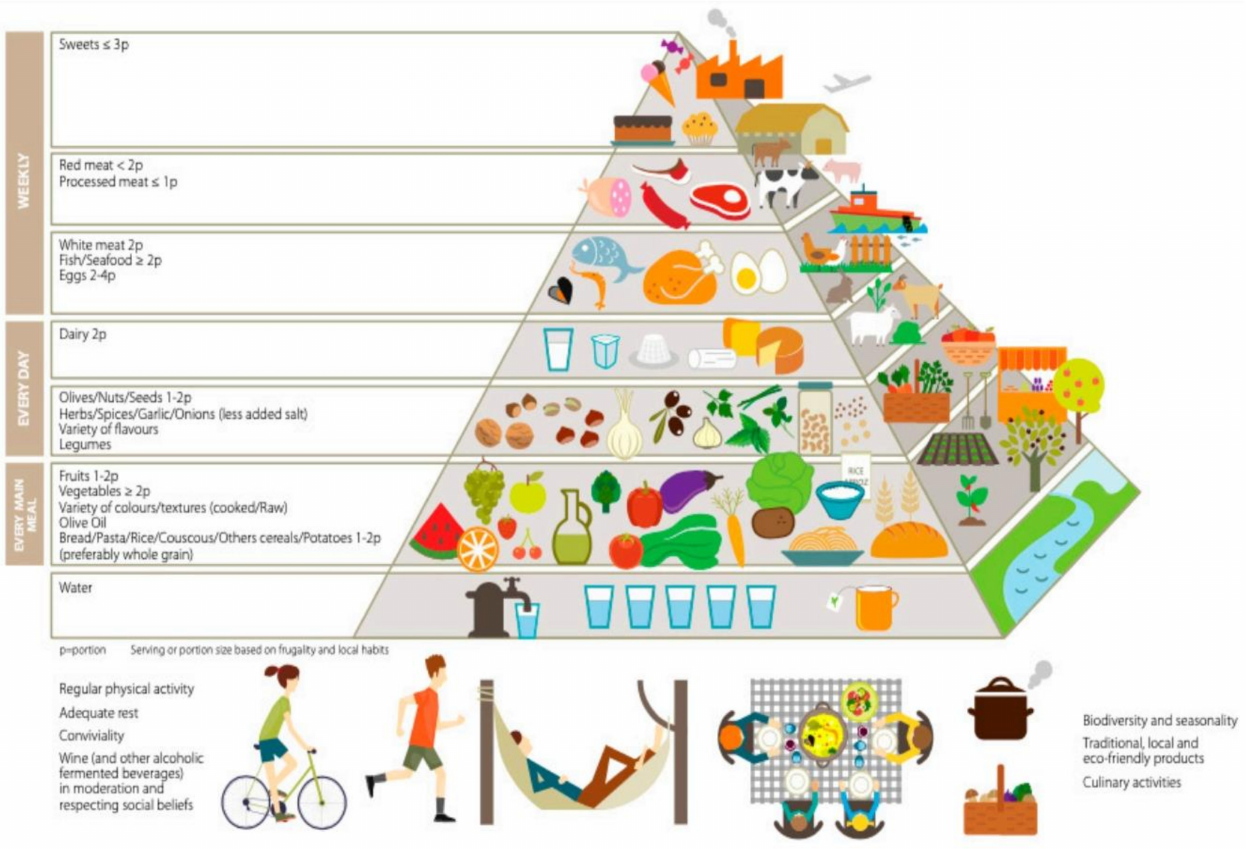
Figure 3. Updated Mediterranean Diet Pyramid